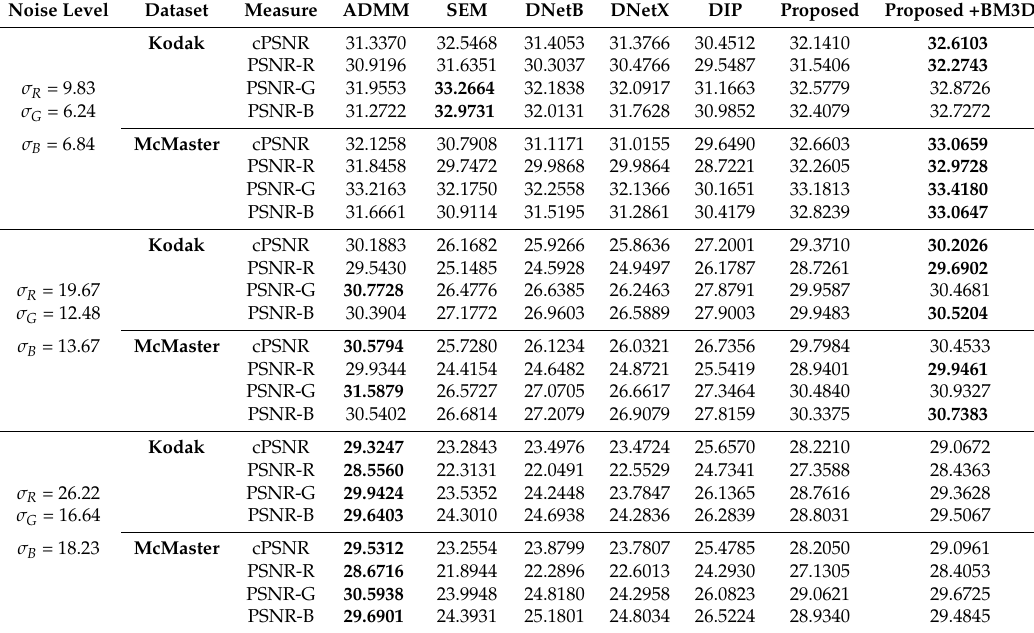
Table 2. Comparison of the PSNR values among the various demosaicing methods on the Kodak and the McMaster image datasets.